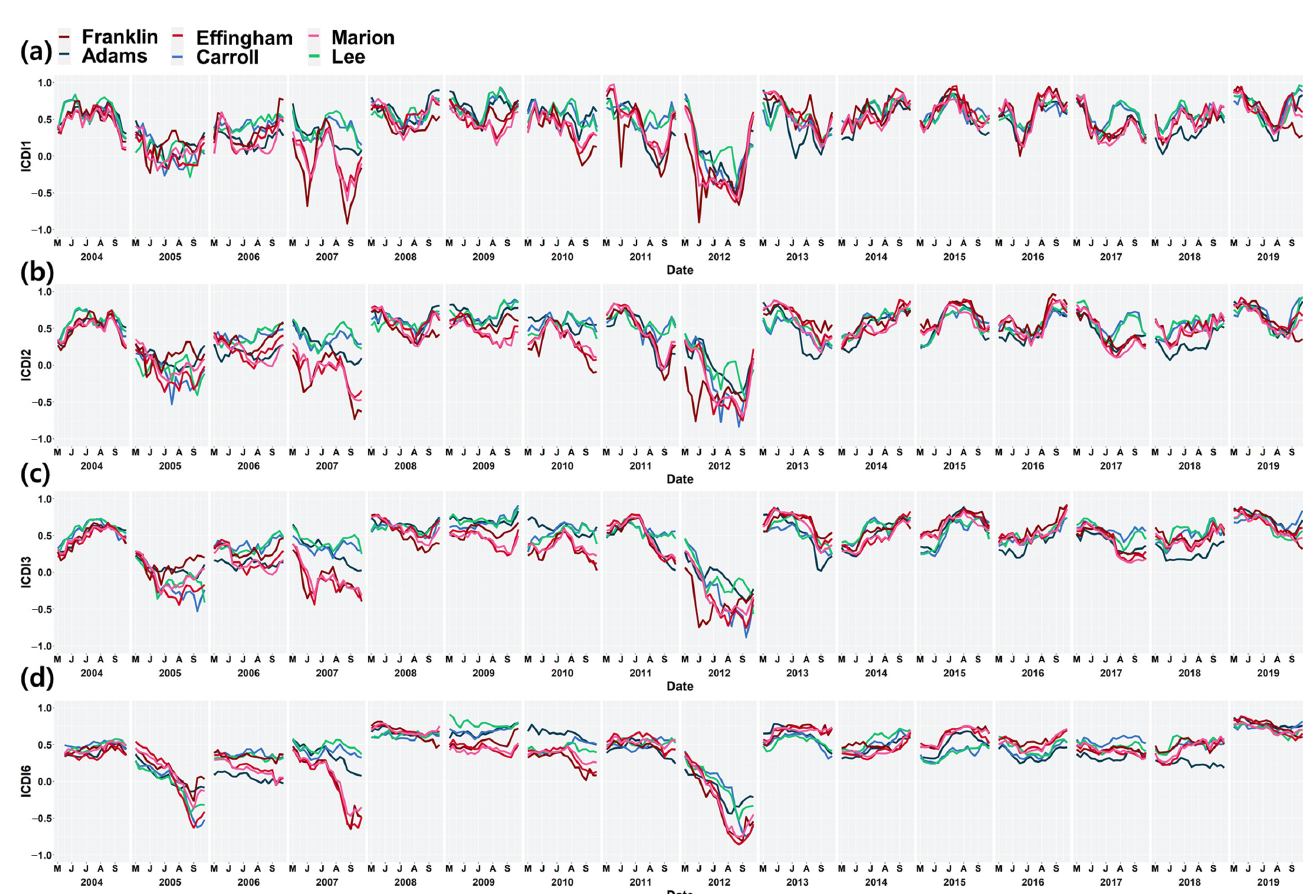
Figure A1. Comparison of ICDI according to the period of moving average: (a) ICDI1 (1 month), (b) ICDI2 (2 months), (c) ICDI3 (3 months), and (d) ICDI6 (6 months).